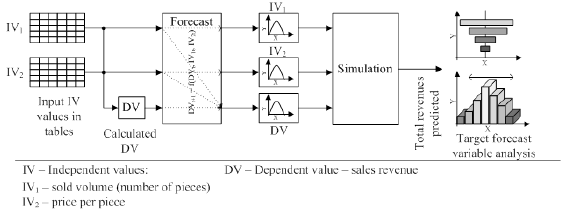
Figure 1: Scheme of forecast and simulation